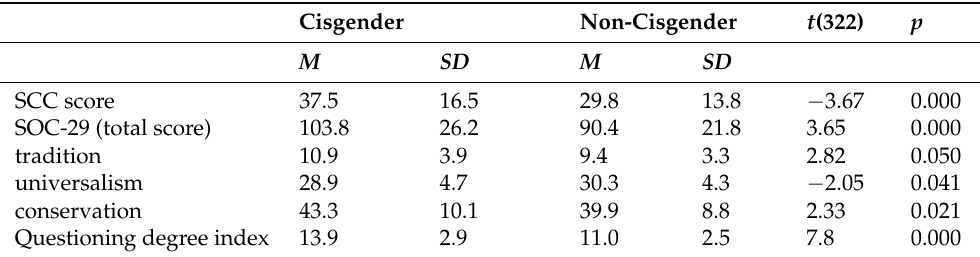
Table 4. Differences between cisgender and non-cisgender people. (Cisgender respondents were defined as individuals who identified themselves as female or male and whose gender identity was consistent with their birth sex. Non-cisgender respondents were defined as individuals who identified as transgender and/or non-binary.).